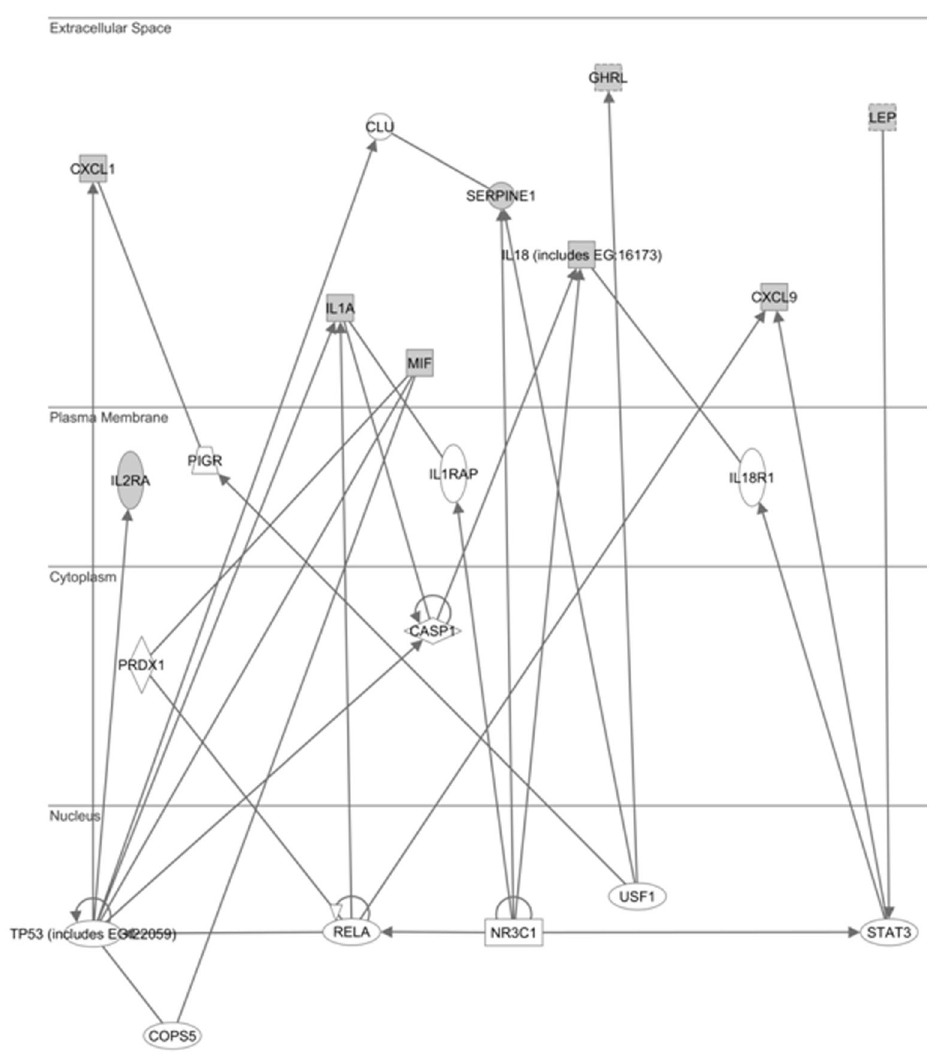
Figure 4. Ingenuity Pathway Analysis (IPA) of significant molecules . The graph shows the closely associated network for significant cytokines, reported also in Table 2, (evidenced with grey symbols) and other molecules (evidenced with white symbols) obtained by IPA